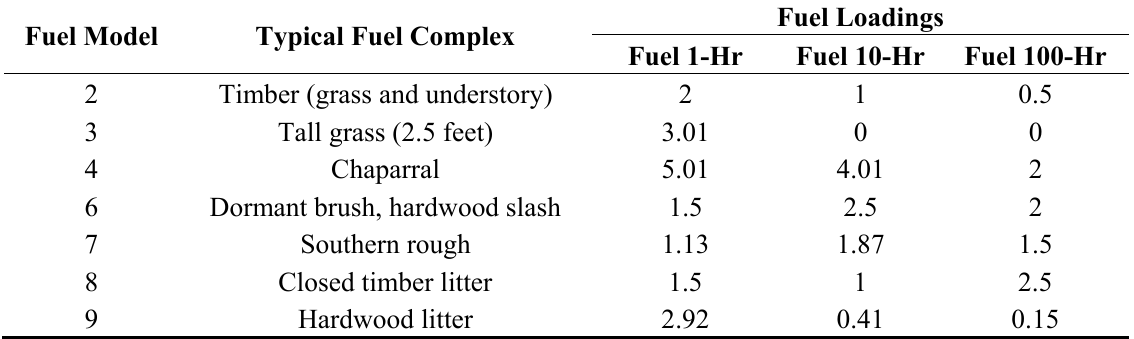
Figure 3. Selected potential areas for fuel treatment. Table 1. Fuel models